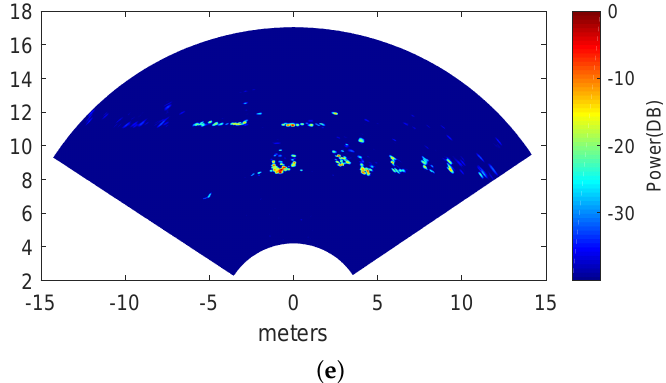
Figure 4. Measured Data. ( a ) Two − dimensional result of the DAS method, ( b ) Two − dimensional results of the IAA method, ( c ) Two − dimensional results of the ADMM − LASSO method, ( d ) Two − dimensional results of the qSPICE method, and ( e ) Two − dimensional results of the ADMM − SPICE